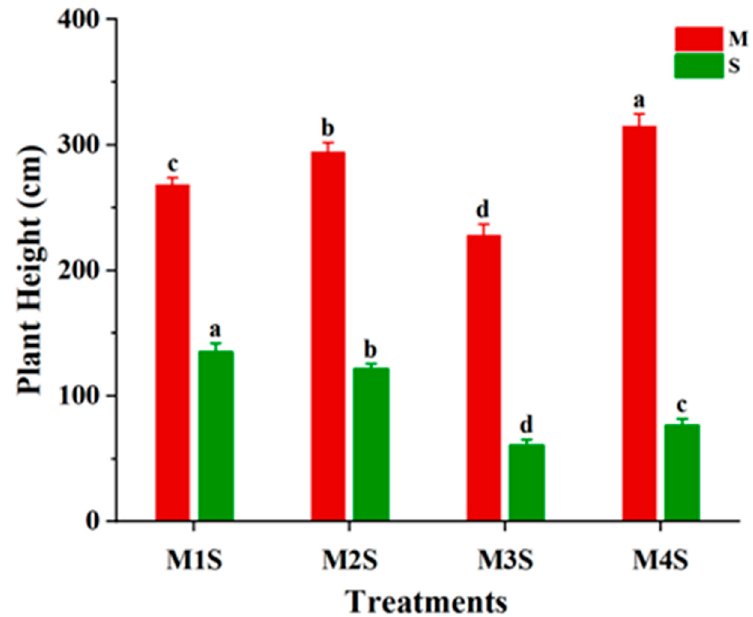
Figure 2. Effects of maize varieties on the plant height of maize–soybean intercropping: M1S, M1 (maize, Rongyu Silage No. 1) and S (soybean, Nanxiadou 25) intercropping; M2S, M2 (maize, Yayu 04889) and S intercropping; M3S, M3 (maize, Demeiya No. 1) and S intercropping; M4S, M4 (maize, Zhenghong 505) and S intercropping; M, average plant height of maize in the corresponding treatment; S, average plant height of soybeans in the corresponding treatment. Means in the same column that do not share the same letters differ significantly ( p < 0.05). Table 3. Effects of maize varieties on the chemical composition of maize in maize–soybean intercropping. Treatments